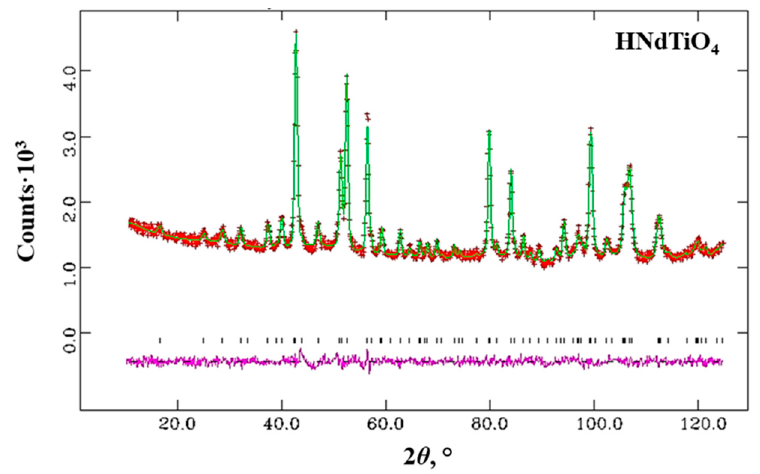
Figure 4. Experimental (red), calculated (green) and differential (purple) profiles of the HNdTiO 4 neutron diffraction pattern. Table 2. Results of the HNdTiO 4 structure calculation based on neutron diffraction data.